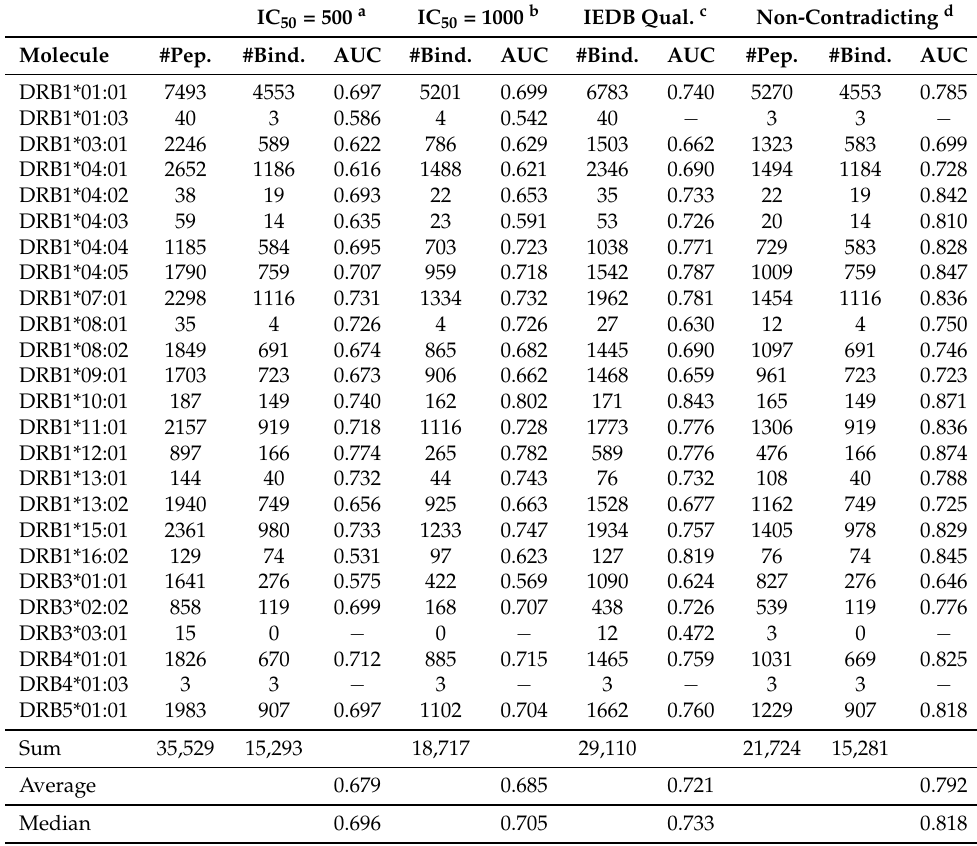
Table 6. Effect of various classification definitions. In literature, no consistent IC 50 cutoff is used to define a peptide as a binder. Further, the qualitative label assigned by authors often contradicts the quantitative value. This table shows the prediction performance on 35,529 IEDB entries on